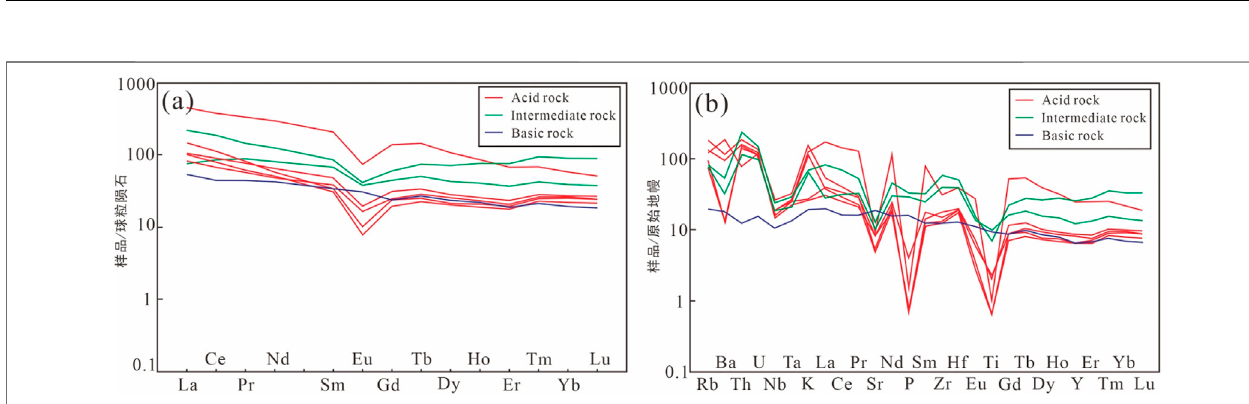
FIGURE 8 | TAS diagram (A) and Nb/Y-Zr/TiO 2 lithology classi fi cation diagram (B) of Carboniferous volcanic rocks in the Shixi area (Pc-Picrite; B-Basalt; O1- Basaltic Andesite; O2-Andesite; O3-Dacite; R-Rhyolite; S1-Trachybasalt; S2-Basaltic Trachyandesite; S3-Trachyandesite; T-Trachyte and Trachydacite; F-Feldspathoidite; U1-Tephrite and Basanite; U2-Phonolitic Tephrite; U3-Tephritic Phonolite; Ph-Phonolite; Ab-Alkaline basalt; Ar-Alkaline rhyolite; and Sb-Subalkaline basalt).